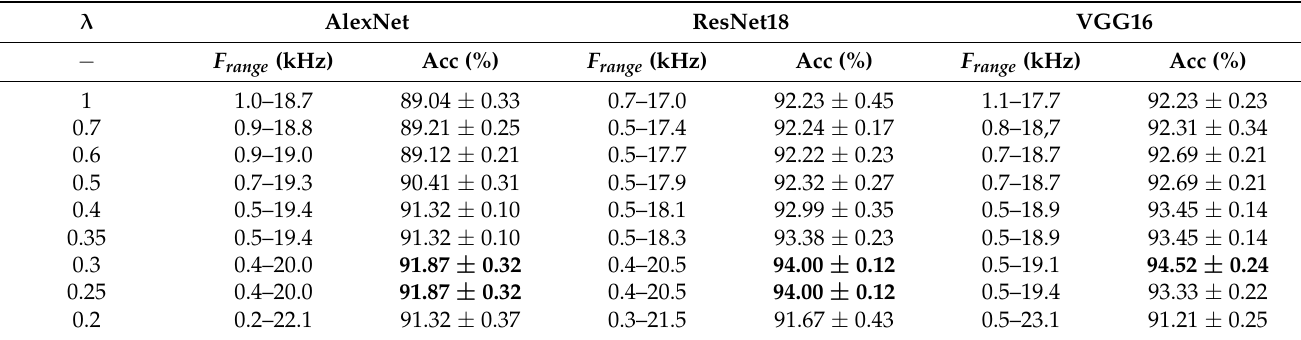
Table 2. Results of different λ on MFPT.